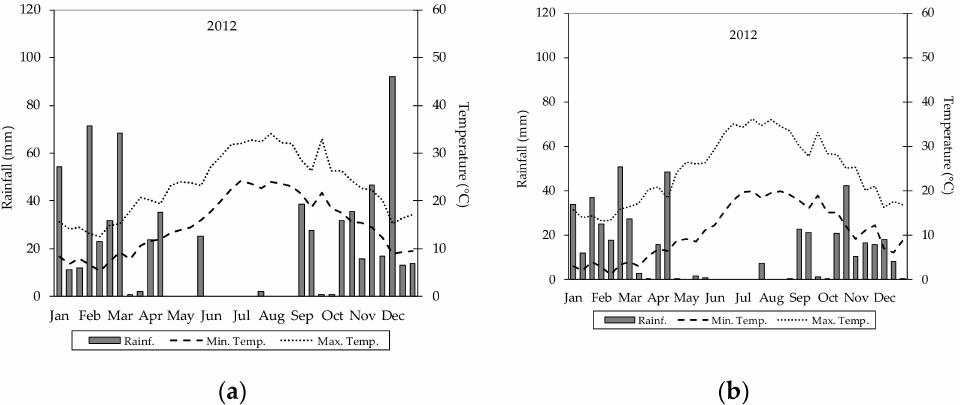
Figure 3. Rainfall and temperature trends in 2012. Graph ( a ) refers to ExpSt_1 area; graph ( b ) refers to ExpSt_2